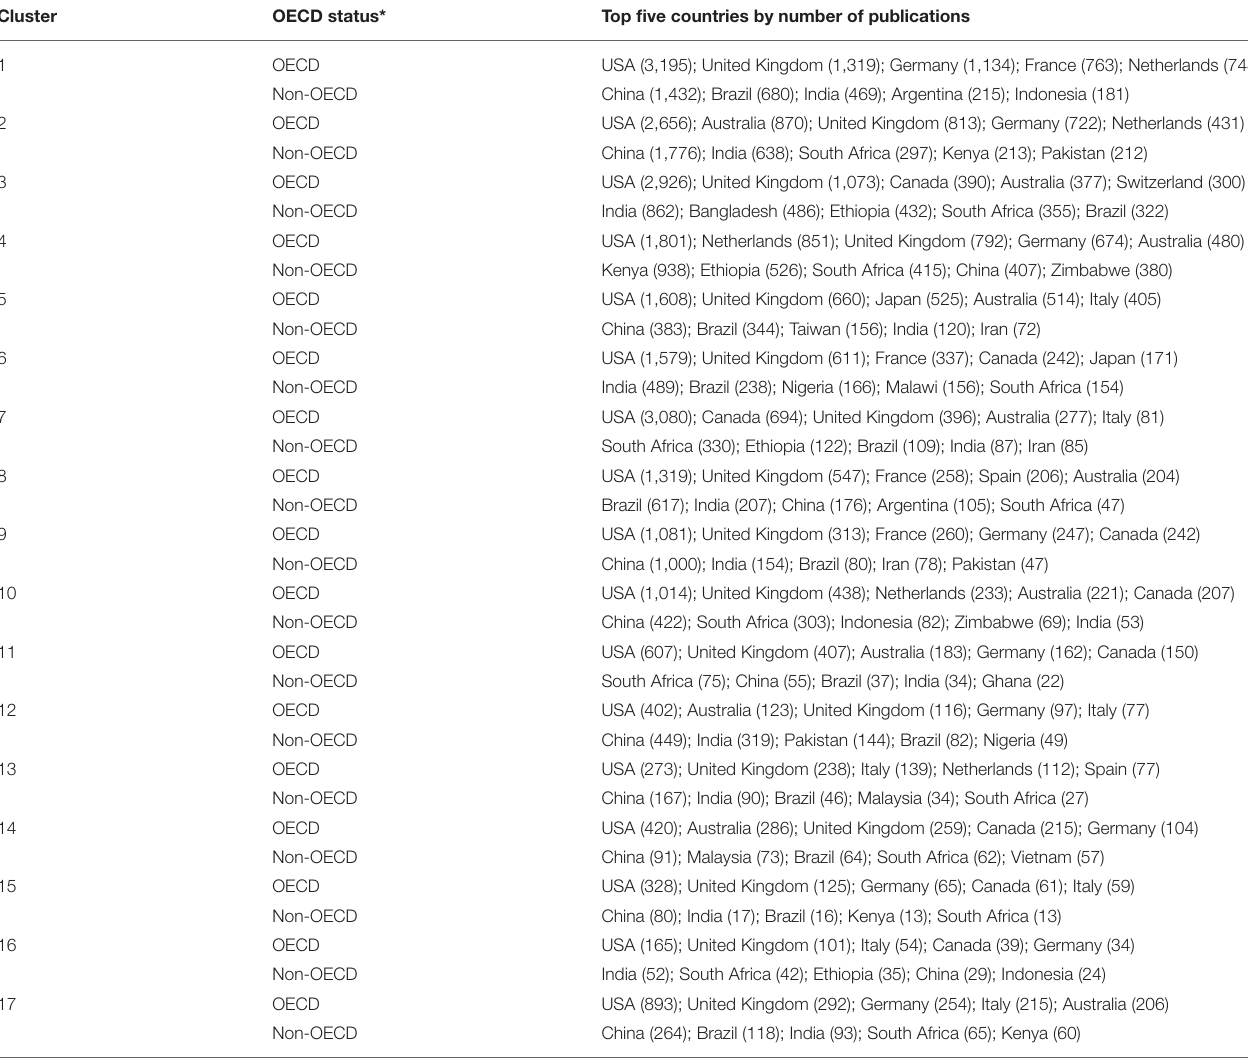
TABLE 4 | Countries with most publications on food security research. Cluster Top five countries by number of publications